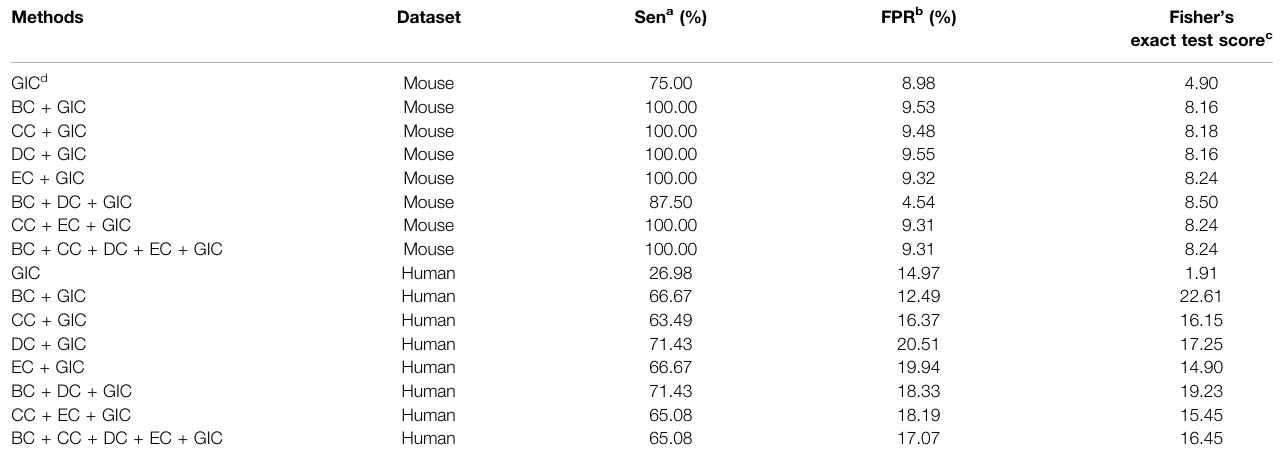
TABLE 1 | Comparison for different con fi gurations of SGII on mouse and human datasets.